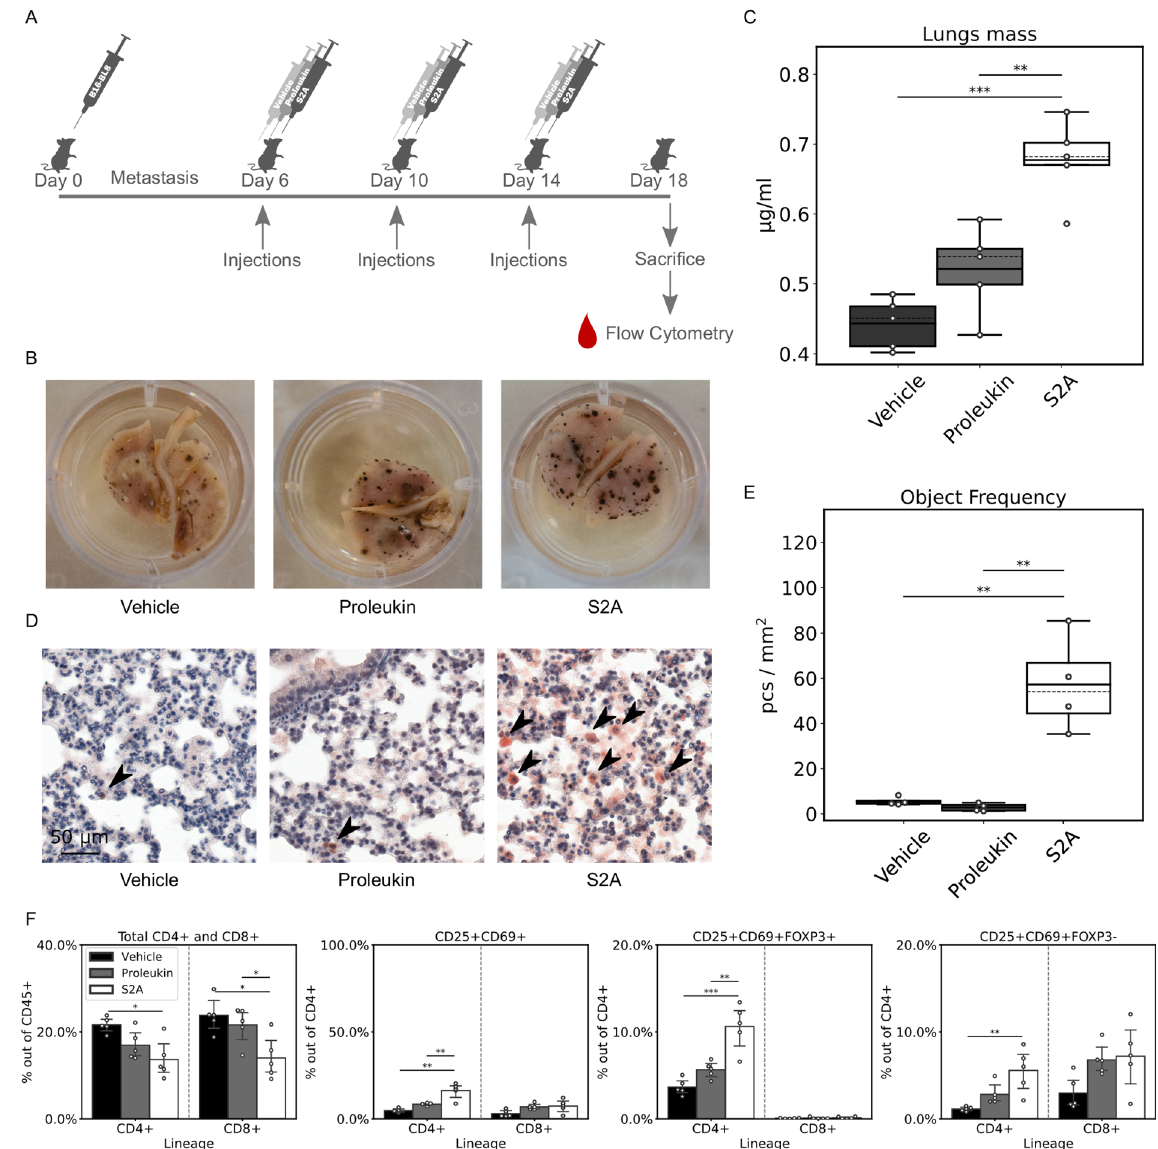
Figure 4. Regulation of B16 growth and Treg frequency in Tumor micro-environment (TME). ( A ) Mice (n = 5 per treatment) were injected with 100,000 B16-BL8 cells i.v. and after 5 days, a session of 3 inoculations, every 4 days was initiated. S2A or Proleukin (30,000 units) were injected at each inoculation. At the 4th day after the last inoculation, mice were sacrificed, and lungs were removed weighed and fixated for immunohistochemistry. ( B ) A representative example of a lung covered with B16 metastasis nodules. ( C ) Lung mass (continuous line— mean, dashed line—median). ( D ) Immunohistochemistry staining of FoxP3 (cells indicated by red arrows) in the representative cut of the metastasized lungs. ( E ) Graph showing the quantitative analysis of FoxP3 immunohistochemical staining in B16-BL8 metastatic lungs. The analysis was performed using Histoquant™ software and expressed in terms of object frequency (pcs/mm 2 ). ( F ) FACS analysis of PBMCs isolated at the day of sacrifice arranged according to lineage and presented as percentage of the population noted on the y-axis. Error bars represent 95% CI. *, P < 0.05; **, P < 0.005; ***, P < S2A were significantly heavier than Proleukin treated or controls (1.3 and 1.5 fold, respectively, P -value < 0.005, Fig. 4C). Immunohistological sections of the lungs were made and stained for FoxP3 to evaluate the tumor